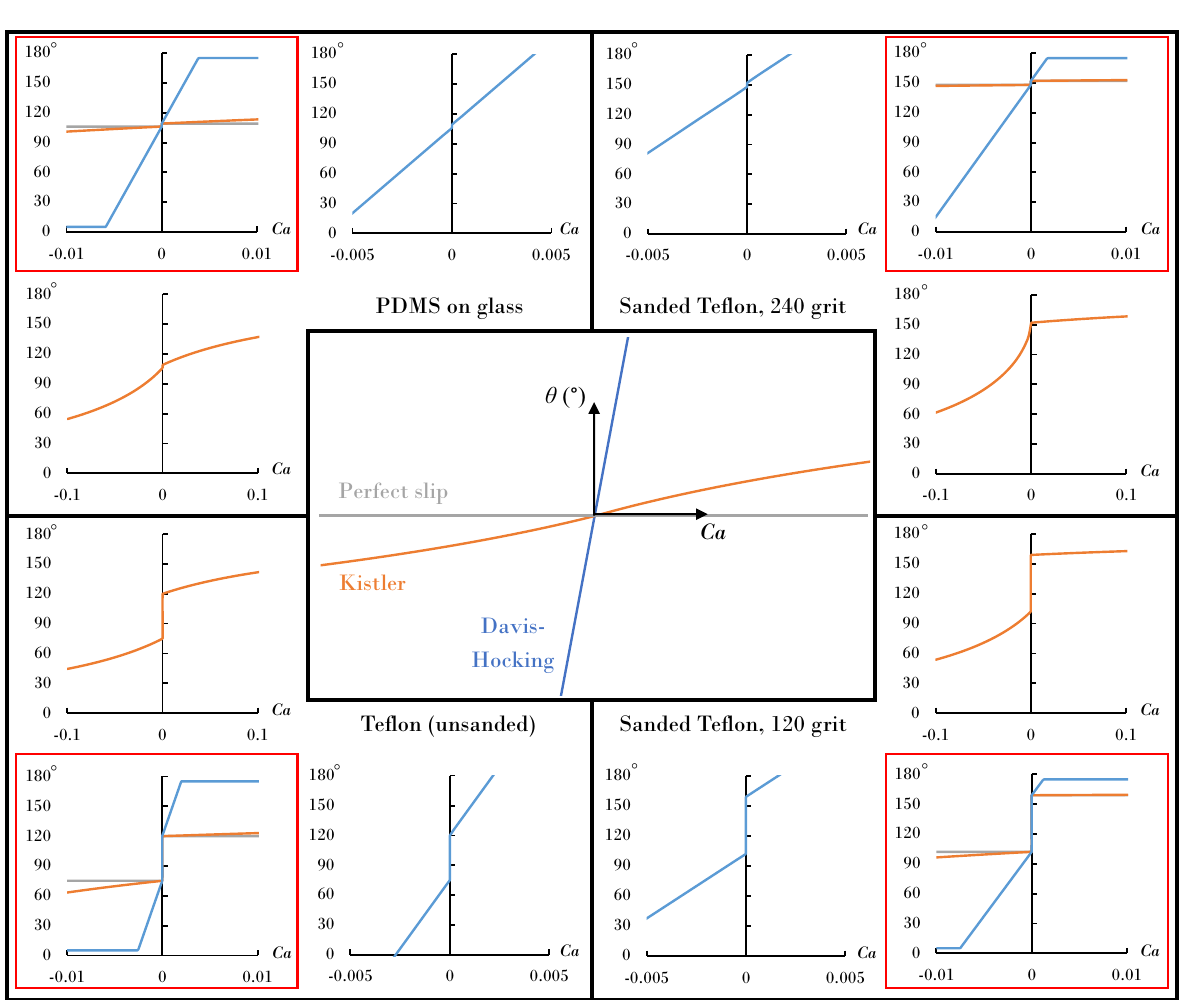
Fig. 3 Family of contact-angle models plotting contact angle against capillary number Ca , contrasting the Davis – Hocking, Kistler, and perfect slip cases (core). The model responses shown on the perimeter incorporate contact-angle hysteresis for the surfaces used in this work. Those in the corners (red framed) indicate model behavior for the range of Ca explored in the current simulations. The other panels show model behavior for alternative Ca ranges.